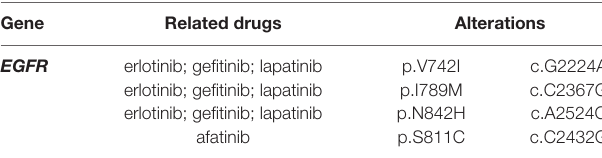
TaBLE 5 | Several new EGFR druggable mutations were discovered by Hotspot3D in patients with lung adenocarcinoma.